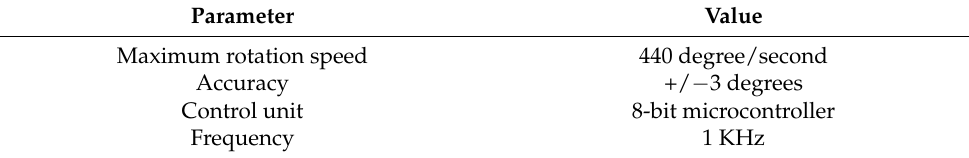
Table 2. General specification parameters for the gyro sensor.